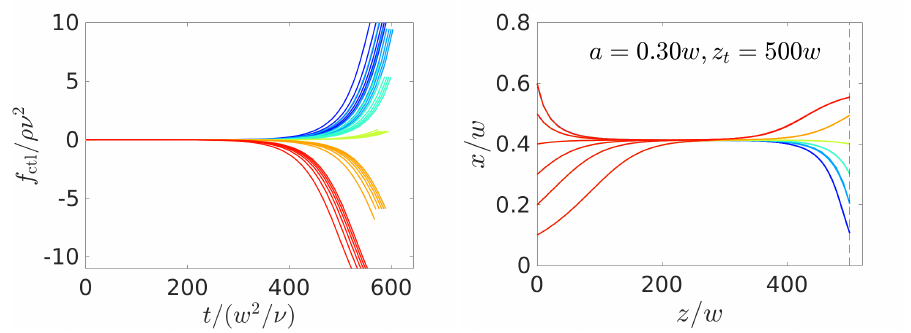
Figure 8. Optimal control-force protocols ( left column) and particle trajectories in the x - z plane ( right column) found for steering colloids with radius a = 0.25 w ( top row) and a = 0.3 w ( bottom row) from a set of initial positions to a set of targets, which both assume the same values The same color refers to trajectories ending at the same target position x t . The vertical dashed line indicates z t